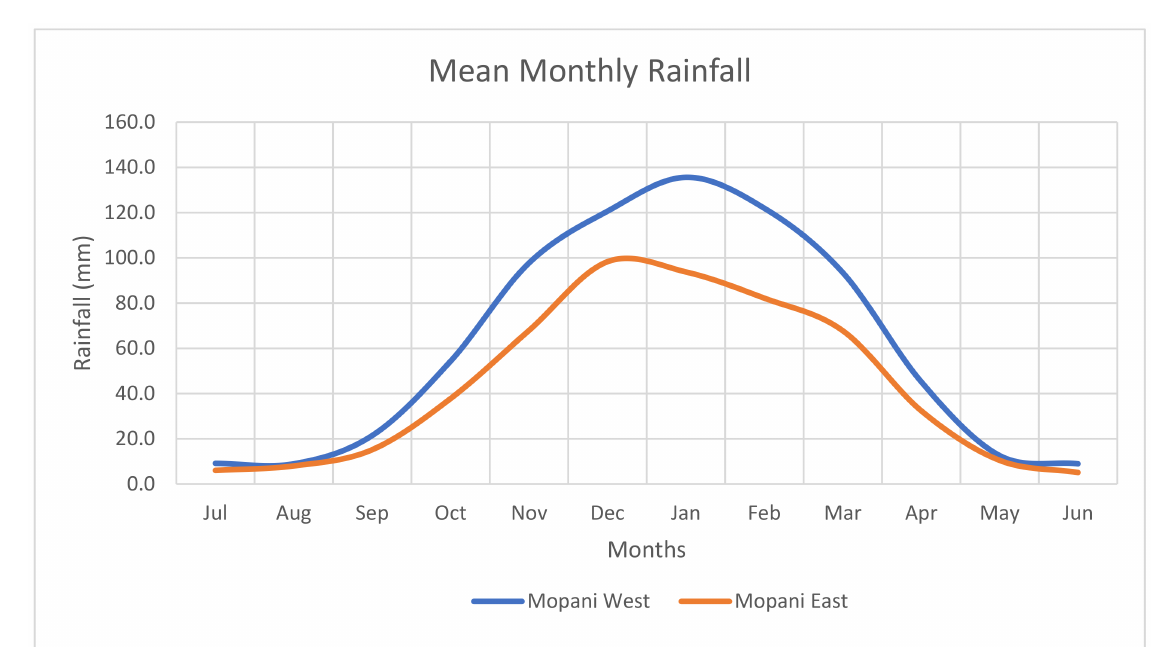
Figure 3. Mean monthly rainfall for Mopani Western bushveld and Eastern lowveld, calculated from a 1980–2016 climatology.